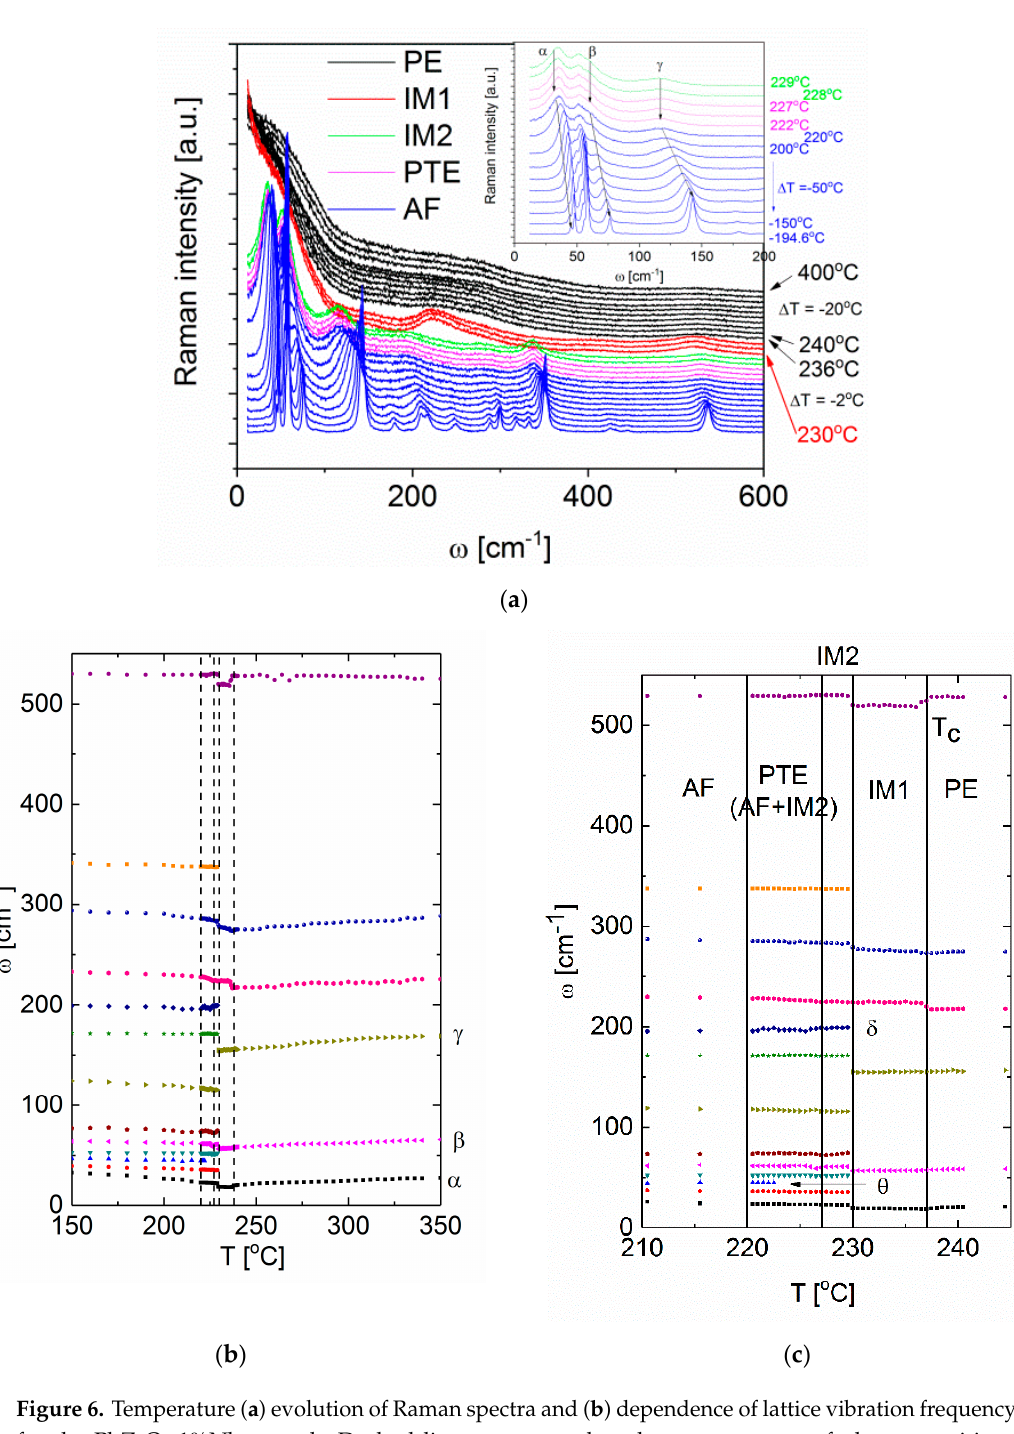
Figure 6 . Temperature ( a ) evolution of Raman spectra and ( b ) dependence of lattice vibration frequency for the PbZrO 3 :1%Nb crystal. Dashed lines correspond to the temperatures of phase transitions determined from dielectric and optical studies [34]; ( c ) temperature lattice vibration frequency in vicinity of phase transitions for the PbZrO 3 :1%Nb crystal.